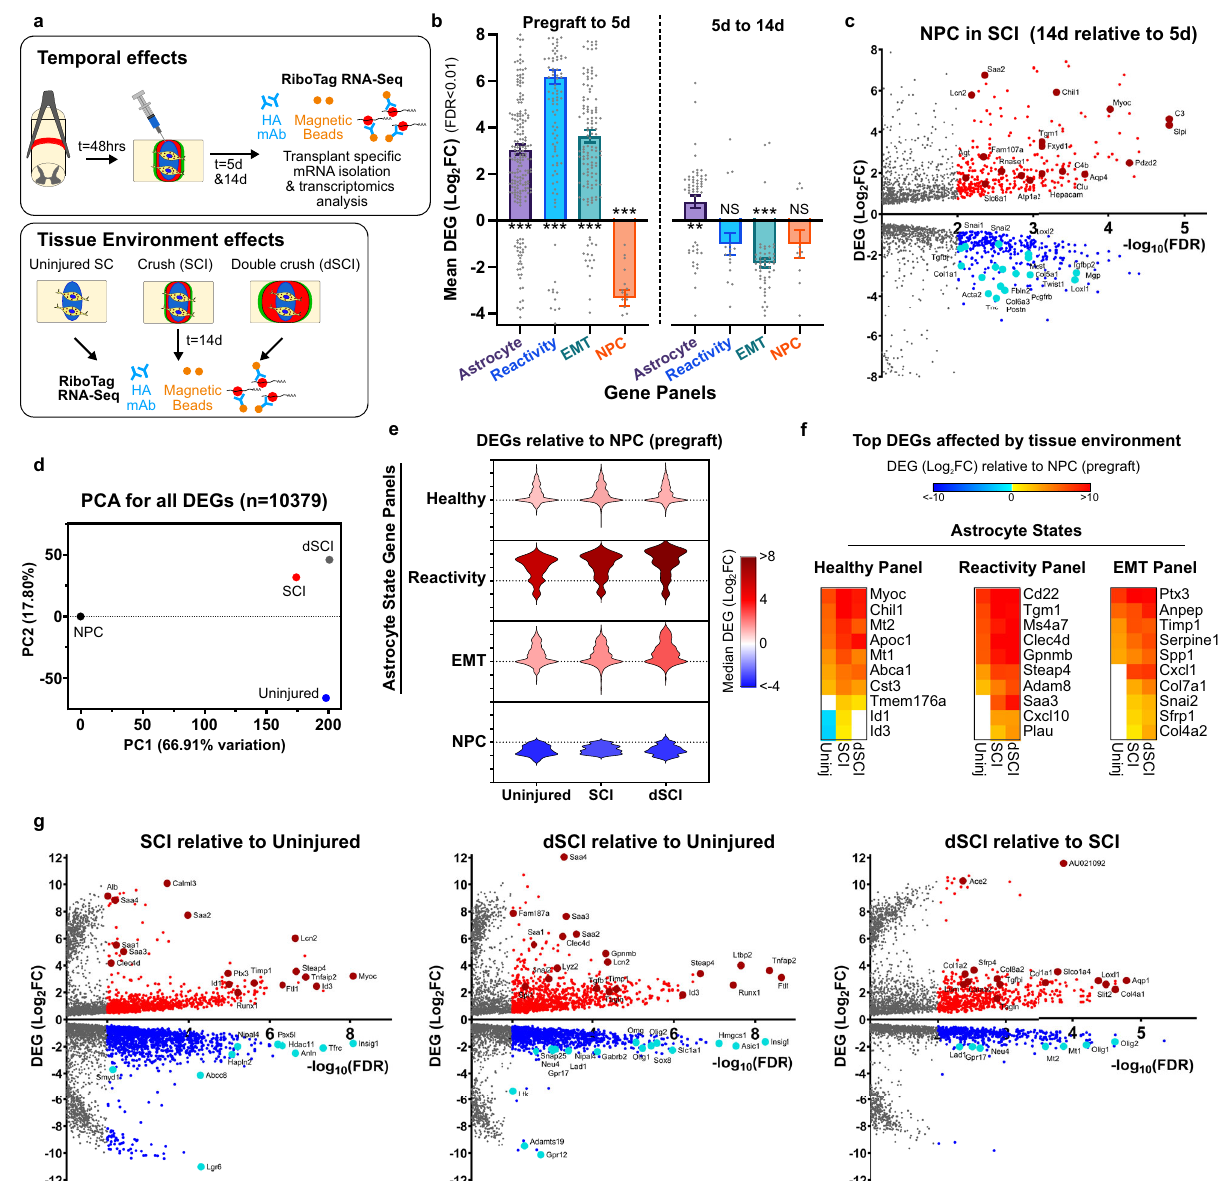
Fig. 8 | Astroglia derived from NPC grafted into subacute crush spinal cord injury mature over time and are altered non-cell autonomously by grafted environment. a Schematic summarizing experimental approach for evaluating temporalandtissueenvironmenteffectsofNPCgraftingintomouseSCI( N =5mice per condition). b Bar graph of DEGs for astrocyte, reactivity, EMT and NPC/pro- genitorgenepanelsforNPCinSCIrecoveredat5daysrelativetoPre-graftNPCand NPC recovered at 14 days relative to 5 days. Expression of all astrocyte state gene panels increased by 5 days whereas NPC gene expression decreased. From 5 to 14 days after grafting, astrocyte gene expression in NPC increased whereas EMT gene expression decreased. *** p value < 0.0005, ** p value < 0.004, One sample t - test(two-tailed)forhypotheticalmean=0.Graphsaremean±s.e.m.andindividual